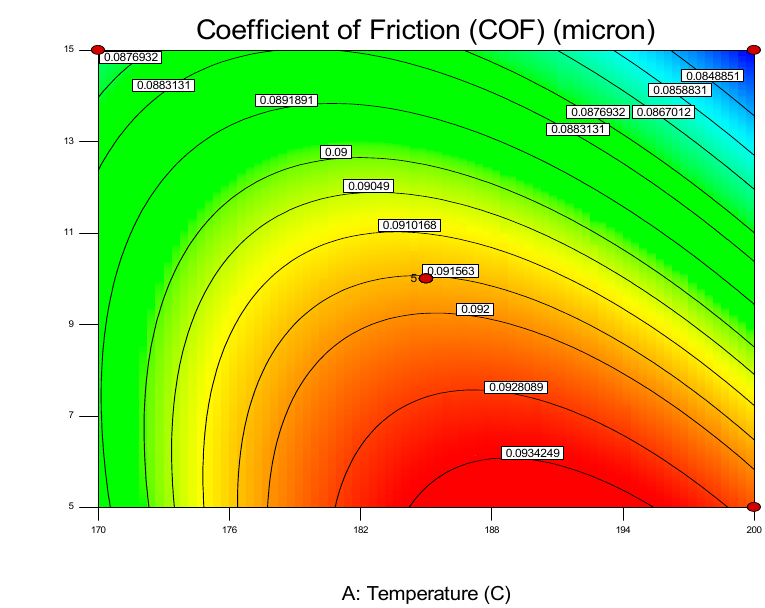
Figure 4. A contour interaction plot of the COF for the MoS 2 nanolubricants. The value of all the residual observations used in the residual plot involves the residual vs. the predicted plot and the residual vs. the experimental run plot. The residual vs. predicted plot and the residual vs. experimental run plot of the COF for the MoS 2 nanolubricants are shown in Figures 5 and 6, respectively, which is the significant diagnosis for the model. According to Draper and Smith [28,29], linear relationships are normal in error terms. Our results have shown no defects, suggesting that errors obey the normal distribution and endorse the experimental